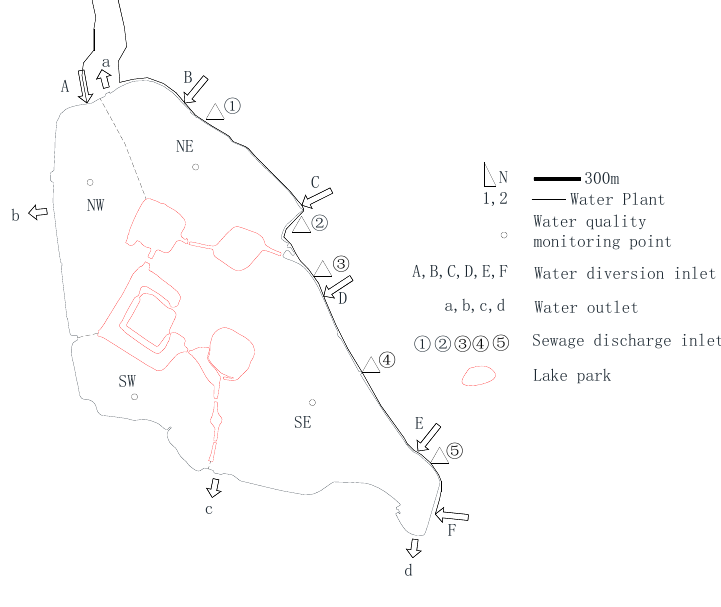
Figure 1. Study area.